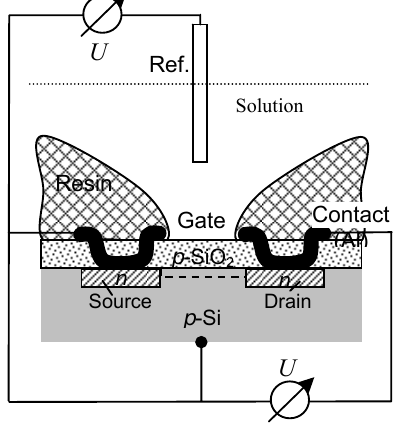
Figure 2. Principle of a solid state pH electrode (ISFET). The SiO 2 layer at the gate is covered by an ionsensitive layer. The gate voltage U reference electrode and n -channel (dashed line between source and